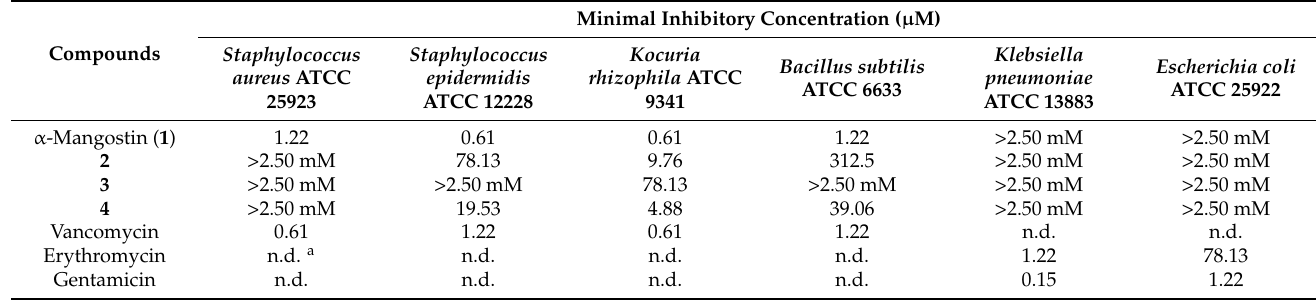
Table 3. Antibacterial activity of α -mangostin and the N -containing analogs 2 – 4 . Minimal Inhibitory Concentration ( µ M) Compounds 25923